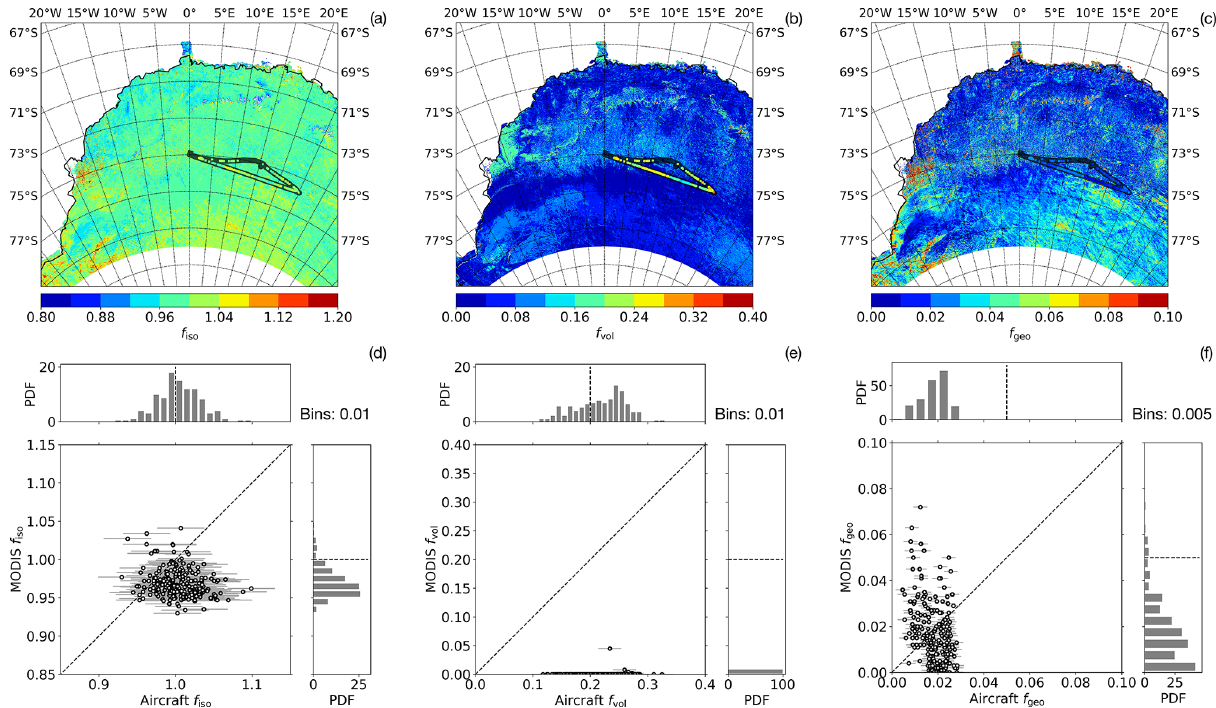
Figure 9. Comparison between airborne (490–585nm wavelength) and MODIS (545–565nm) retrievals of f k for the research flight on 29 December 2013. (a) Map of the area covered by the research flights; the colored contours correspond to the MODIS retrieval of f iso . Black: flight track on 29 December 2013. Colored circles on black flight track: airborne retrieval of f iso . (b) As in (a) but for f vol . (c) As in (a) but for f geo . (d) Corresponding combined scatter plot and histograms between airborne and satellite (resampled on flight track) retrieval for f iso . Error bars correspond to the mean SD of the airborne retrieval. Dashed line in scatter plot: 1 : 1 line. Dashed line in histograms: center of axis. (e) As in (d) but for f vol . (f) As in (d) but for f geo